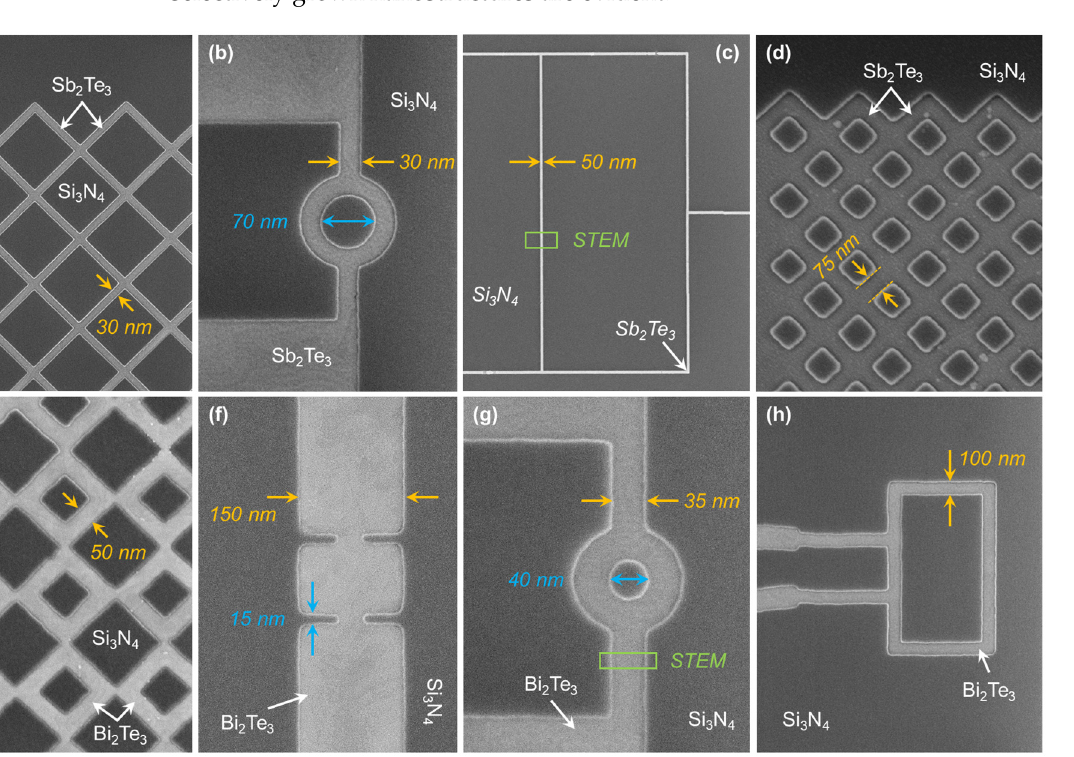
Figure 5. Examples of SAE with controlled R eff = 5 nm/h, conducted on different substrates where R TF is adjusted according to the dimensional parameters. Scanning electron micrographs (SEM) of selectively grown nanostructures of Sb 2 Te 3 ( a – d ) and Bi 2 Te 3 ( e – h ) reaching quasi ‐ 1D limits confirming the possibility of achieving a scalable network of topological nanostructure adoptable to arbitrary layouts.